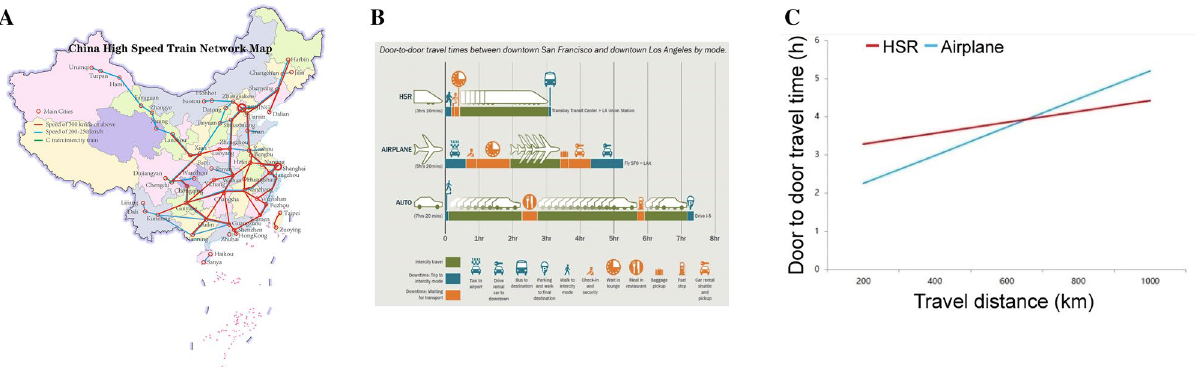
Figure 4. ( A) China HST Network Map (updated on December 2019). The map was created with Adobe Illustrator CS5 (US), https:// www. adobe. com/ cn/ produ cts/ illus trator. html. ( B ) Door-to-door travel time between San Francisco and Los Angeles by different transports. ( C ) Door-to-door travel time by different distances between high-speed train and